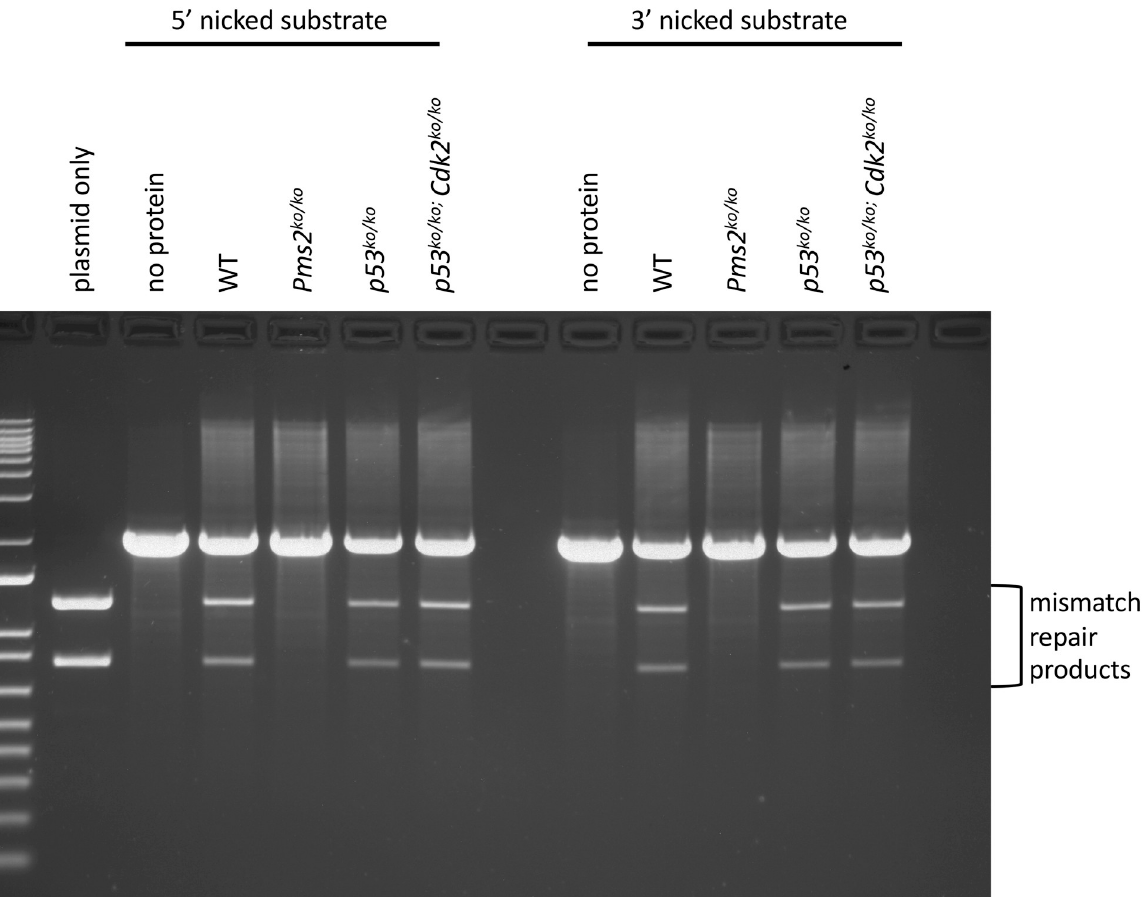
PLOS ONE | https://doi.org/10.1371/journal.pone.0283590 March 23,